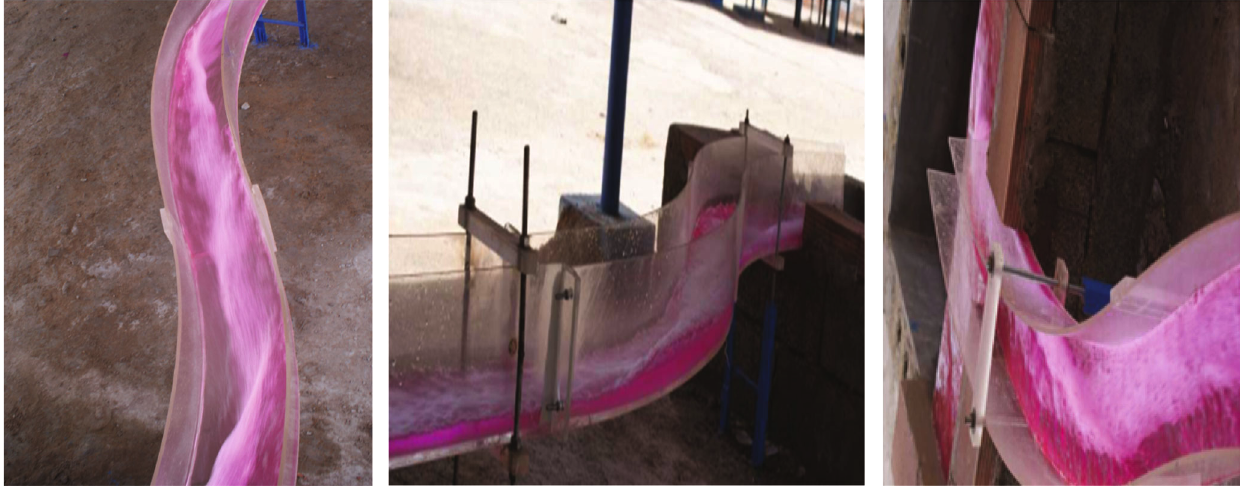
Figure 8: Water surface and rooster tail waves for the bottom outlet in the physical